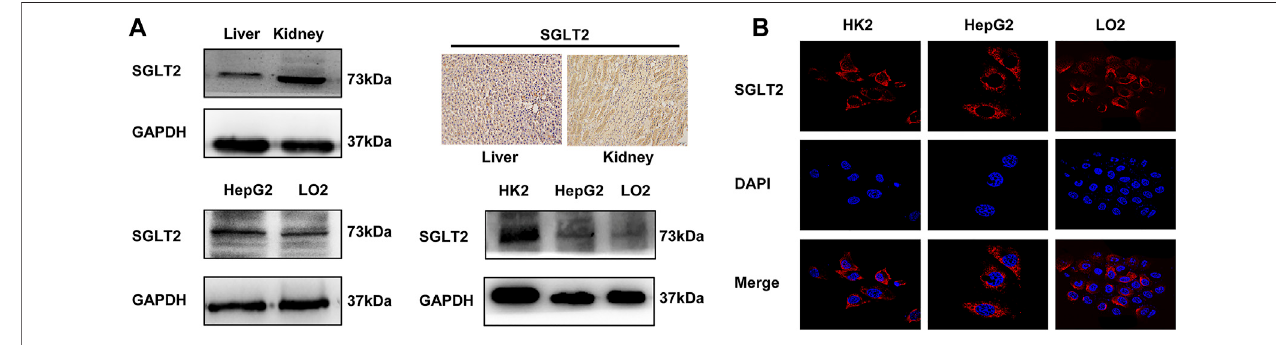
FIGURE 3 | Expression of SGLT2 in rat liver and LO2 and HepG2 cells. (A) Western blot analysis and IHC staining demonstrate the protein expression level of SGLT2 in rat liver and kidney tissues. (B) Western blot analysis and immuno fl uorescence staining show the expression of SGLT2 in human hepatic cell